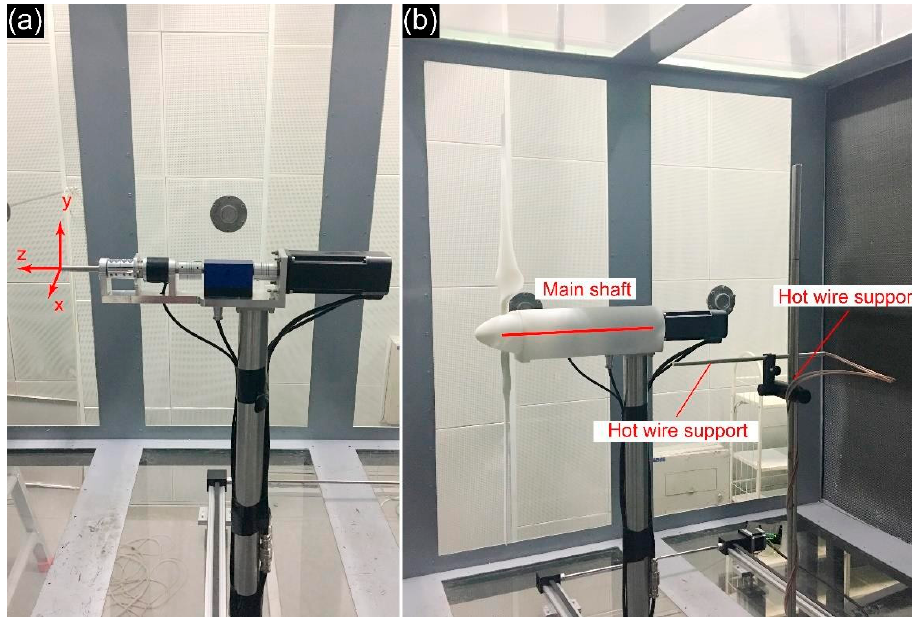
Figure 6. ( a ) Wind turbine model and coordinate system ( b ) hotwire anemometer probe location.